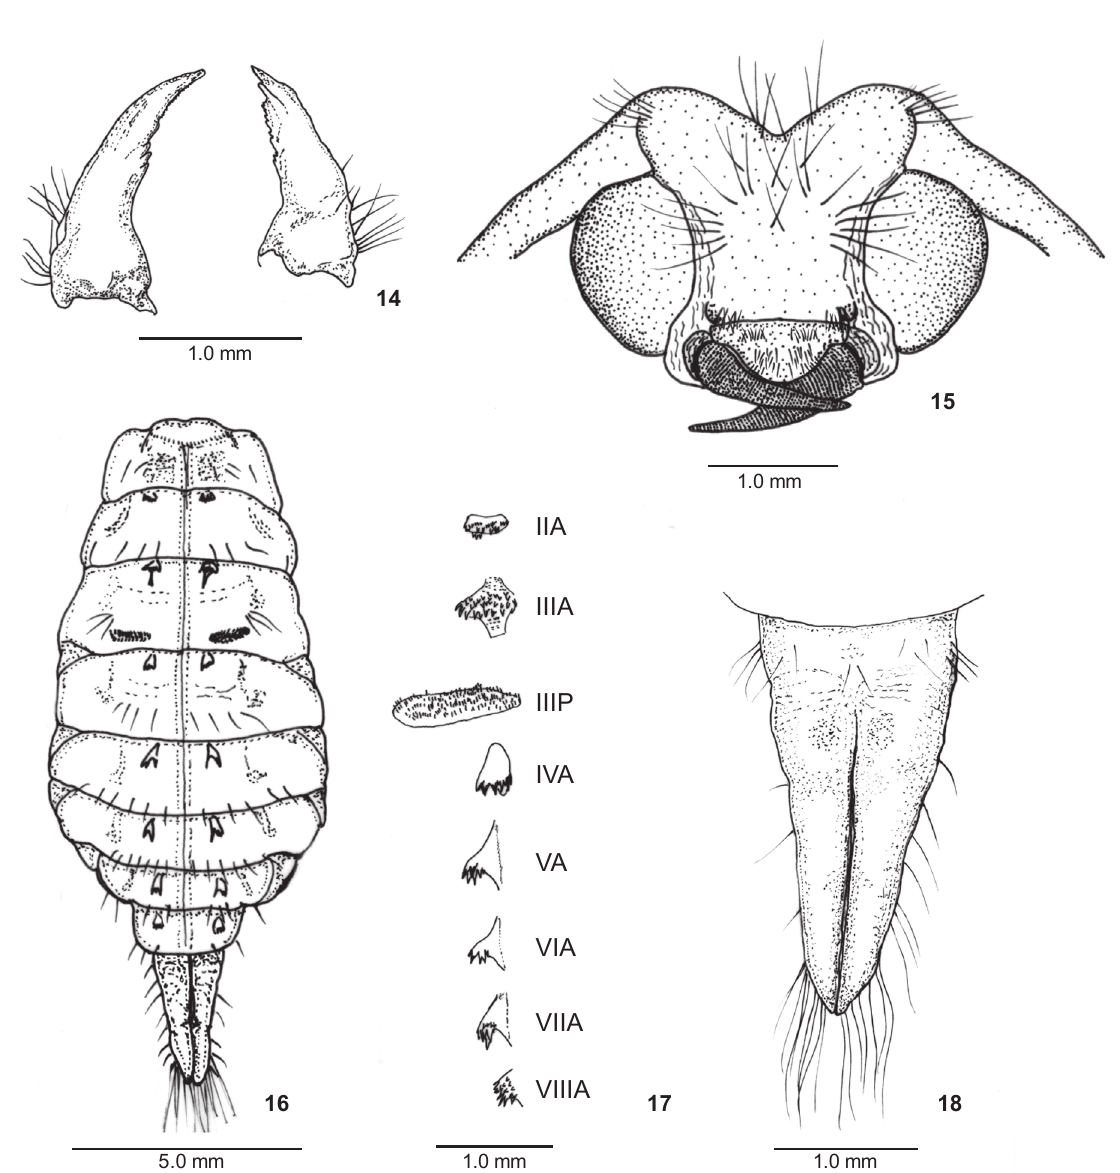
Figures 14-18. Leptonema tridens , pupa: (14) mandibles, dorsal view; (15) head, frontal view; (16) abdomen, dorsal view; (17) hook plates, dorsal view; (18) apex of abdomen, dorsal